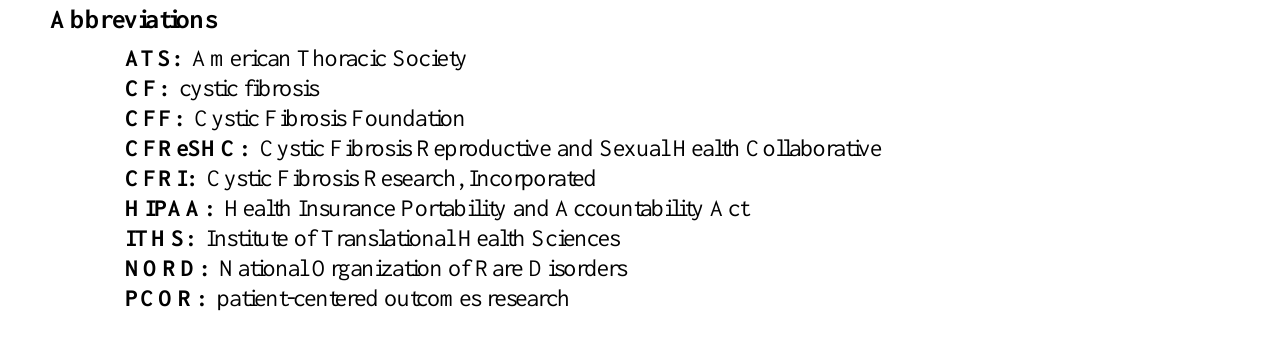
NORD: National Organization of Rare Disorders PCOR: patient-centered outcomes research